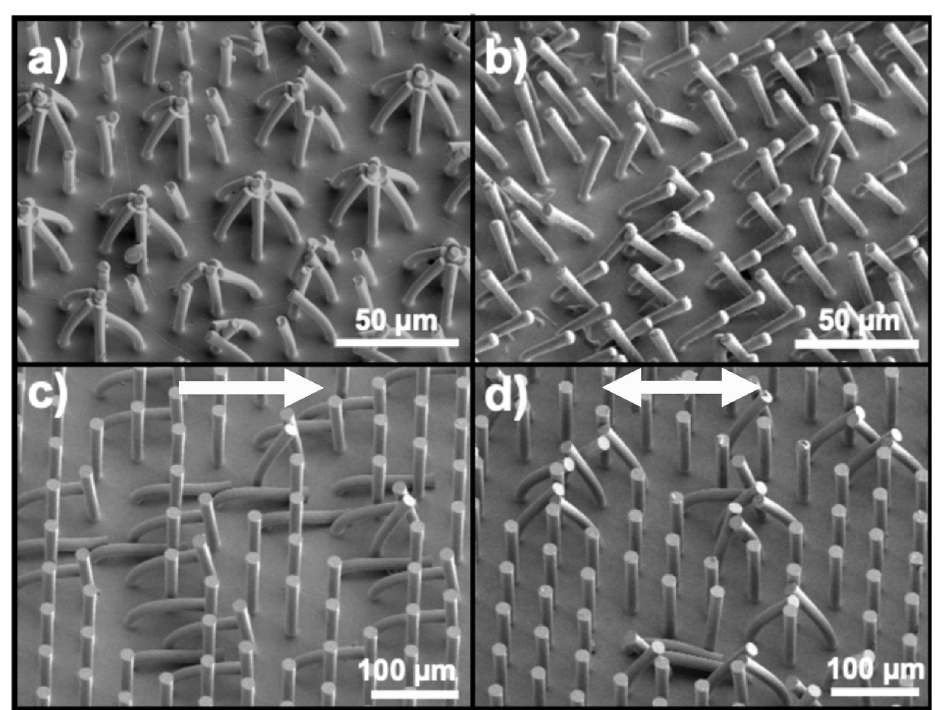
Fig 4. Representative SEM images showing the deformation of micropillar arrays. Panel (a) shows an example of “clustering” lateral collapse by the 6 μ m diameter elements for the compliant ( E = 10 MPa ) material. In contrast, panel (b) shows the stiffer material ( E = 1000 MPa ) with the same geometry exhibiting pairwise lateral collapse. Both images (a) and (b) were taken in the bidirectional region of the travel path of the replica finger. To illustrate the role that unidirectional versus bidirectional travel can play in the deformation mode of micropillars, images (c) (unidirectional) and (d) (bidirectional) are taken from the same sample.